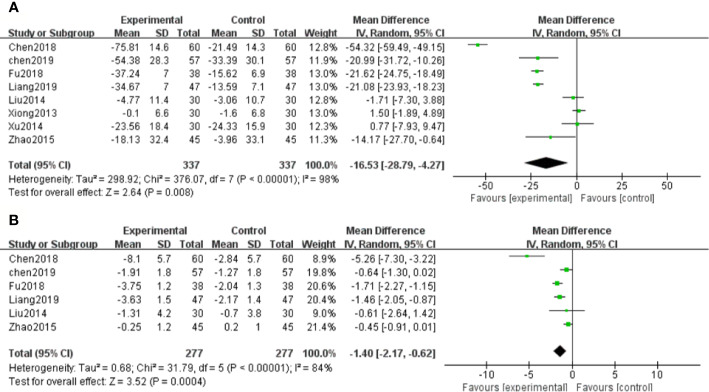
Forest plot for serum creatinine (Scr) between the treatment group and control group (A). Forest plot for blood urea nitrogen (BUN) between the treatment group and control group (B).